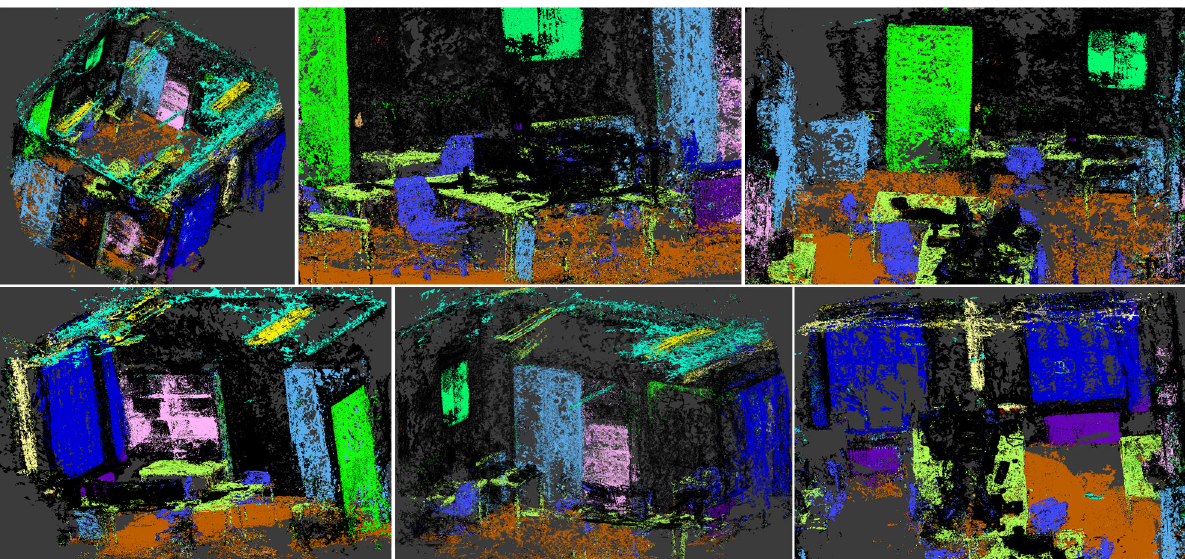
Figure 4. Different views of the classified point cloud. A sharp distinction between categories is visible. Therefore, there are no more darkened colours in the area of the green door.